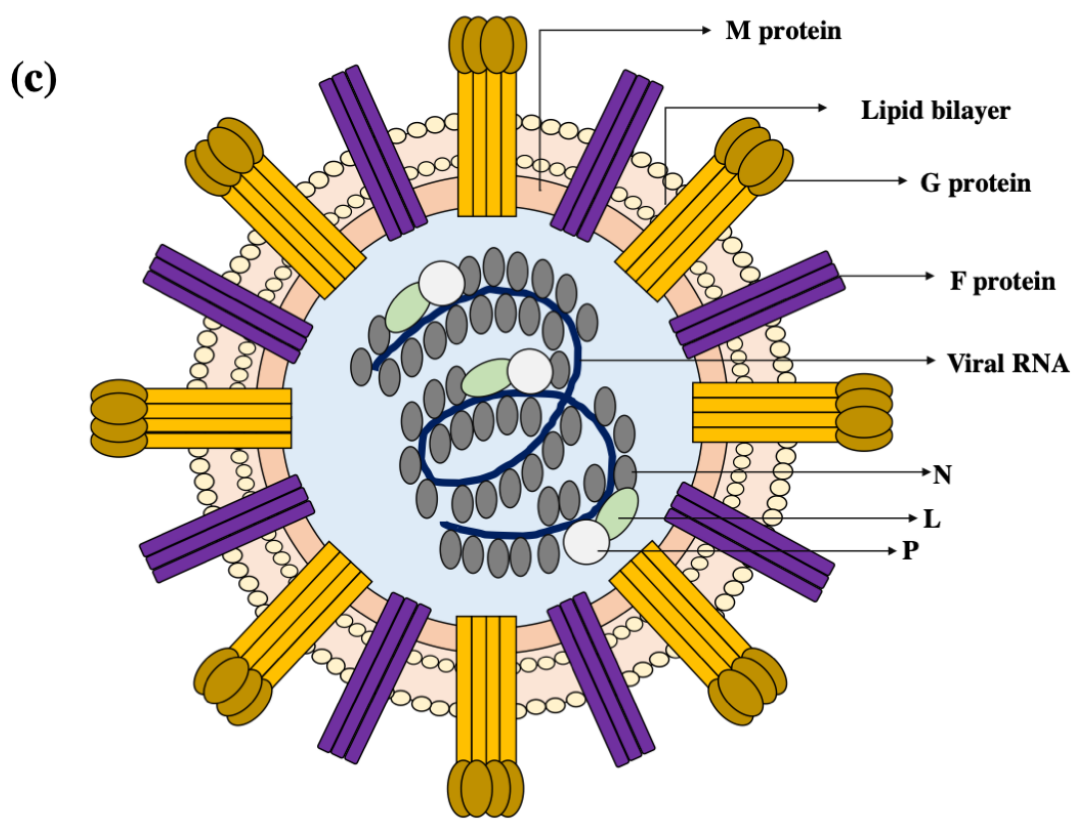
Figure 1. Henipavirus genome organization and virion structure (not true to scale). ( a ) The henipavirus genome is a single stranded negative polarity RNA containing six viral genes. ( b ) The P gene encodes P, V, W, and C proteins possess IFN-antagonist activity. P, V, and W share a common sequence encoding their N-terminal domain (2404–3628 nucleotides (nt)), however at site AAAAAGGGC (3619–3628 nt) RNA editing can occur with a single G-nucleotide (1G) or double G (2G) insertion shifting the reading frame resulting in unique C-terminal domains for V and W proteins respectively; C-terminus of the P protein is longer (202 aa) when compared to W and V (43 and 49 aa, respectively). ( c ) Pleomorphic virion structure is controlled by M protein which lies under the virion envelope. Attachment protein G and fusion protein F are located on the envelope surface and protrude as spikes. The viral ribonucleoprotein (RNP) core consists of a single-stranded negative sense RNA, with N, L, and P proteins required for viral transcription.